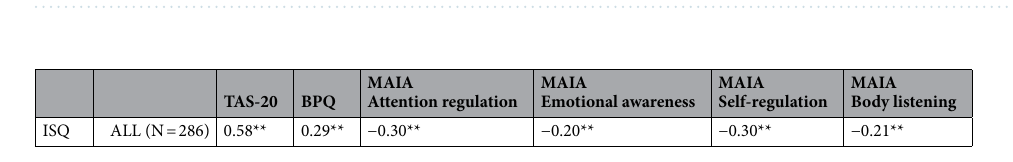
ISQ Table 4. Correlations between ISQ and convergent validity measures. * p < 0.05, ** p < 0.01.